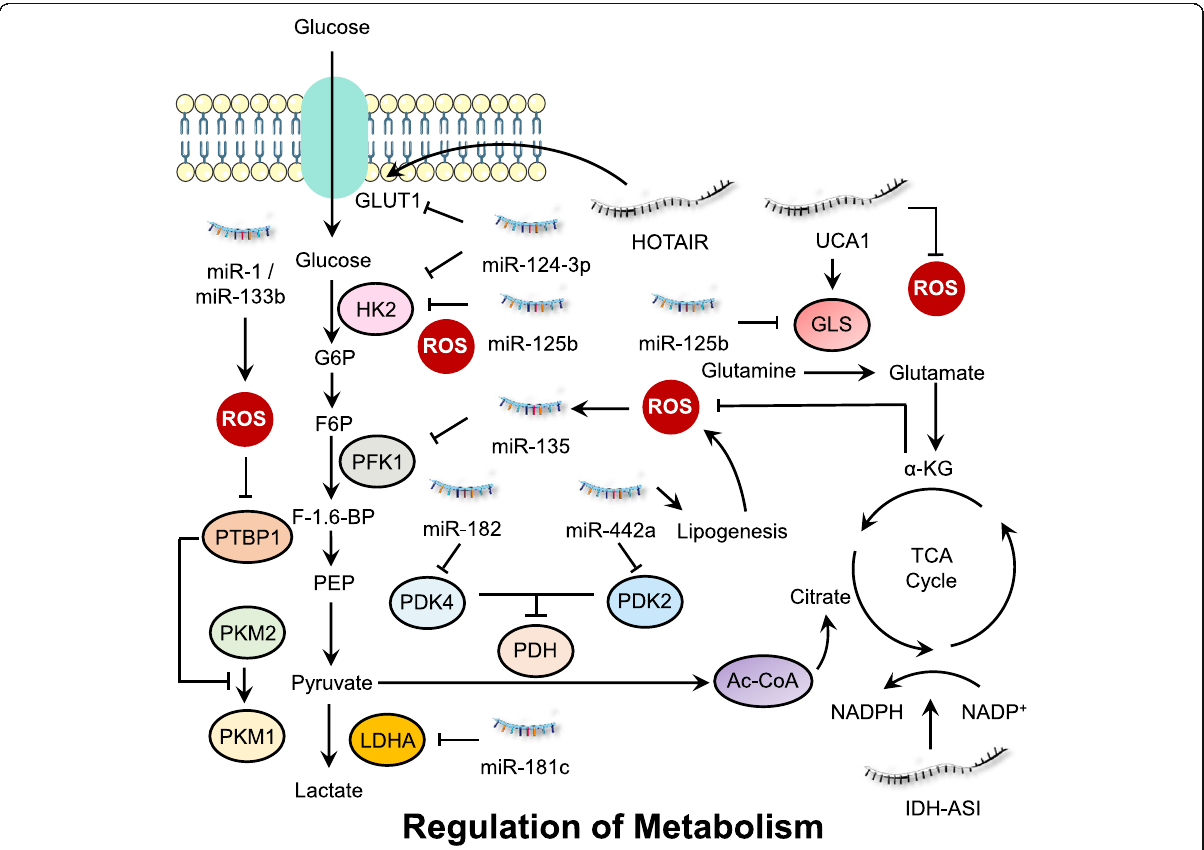
Fig. 4 Interplay between ROS and ncRNAs in regulating cell metabolism. Cancer cell metabolism (including glucose, amino acid and lipid metabolism) are tightly regulated by the interaction between ROS and ncRNAs, which generate energy or metabolic intermediates to support cancer cell